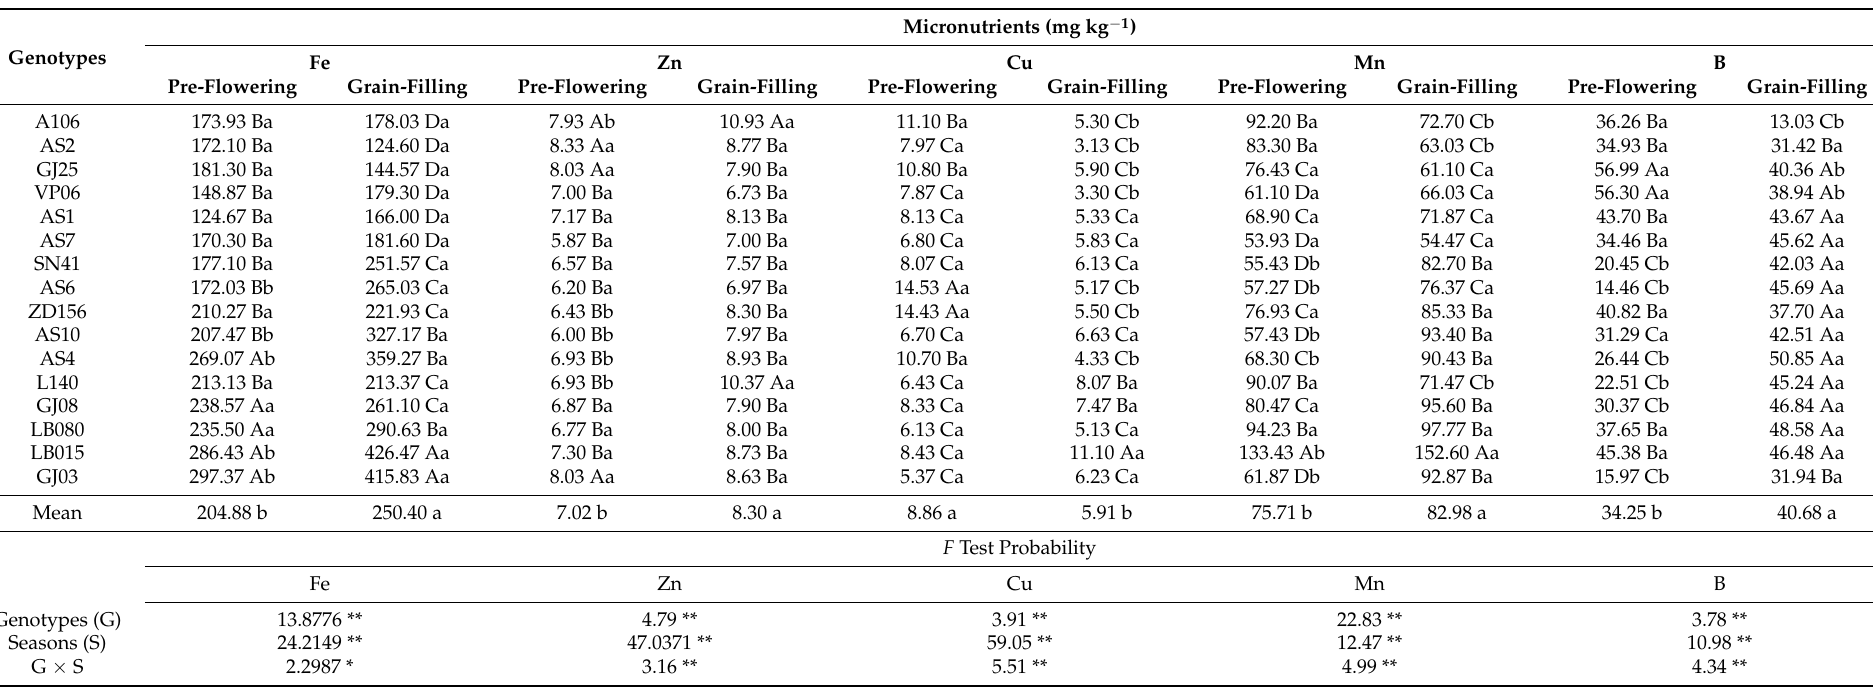
Table 8. Leaf micronutrient concentrations in 16 Coffea canephora genotypes during the pre-flowering and grain-filling periods. Alta Floresta D’Oeste, Rond ô nia,